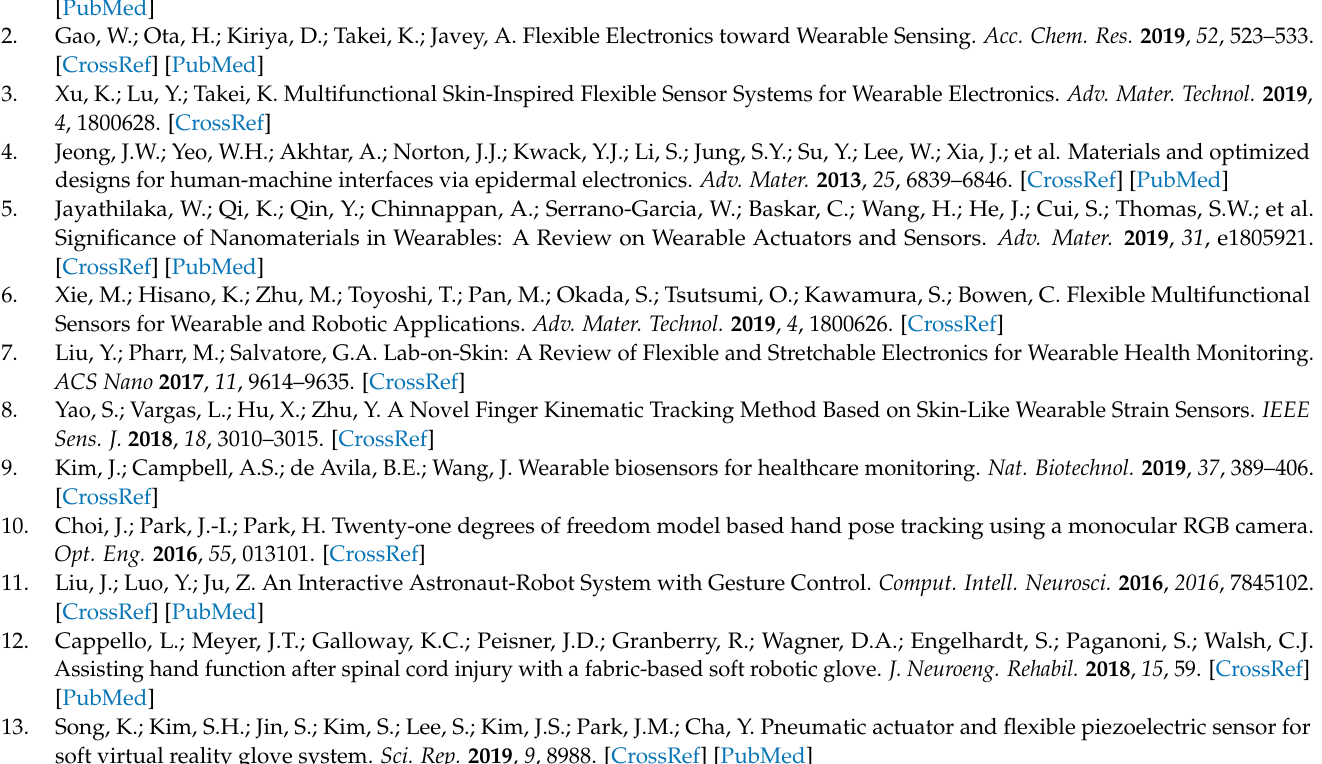
of the data glove. Figure S1: Elastic fiber with different bending radius. Figure S2: The measurement process of the maximum stretching range of U-shaped fiber. Figure S3: The physical picture of the indentation test. Figure S4: The definition of a cycle in a bending cycle test. Video S1: dynamic demonstration of cyclic stretching. Video S2: gesture tracking demonstration of manipulator and data